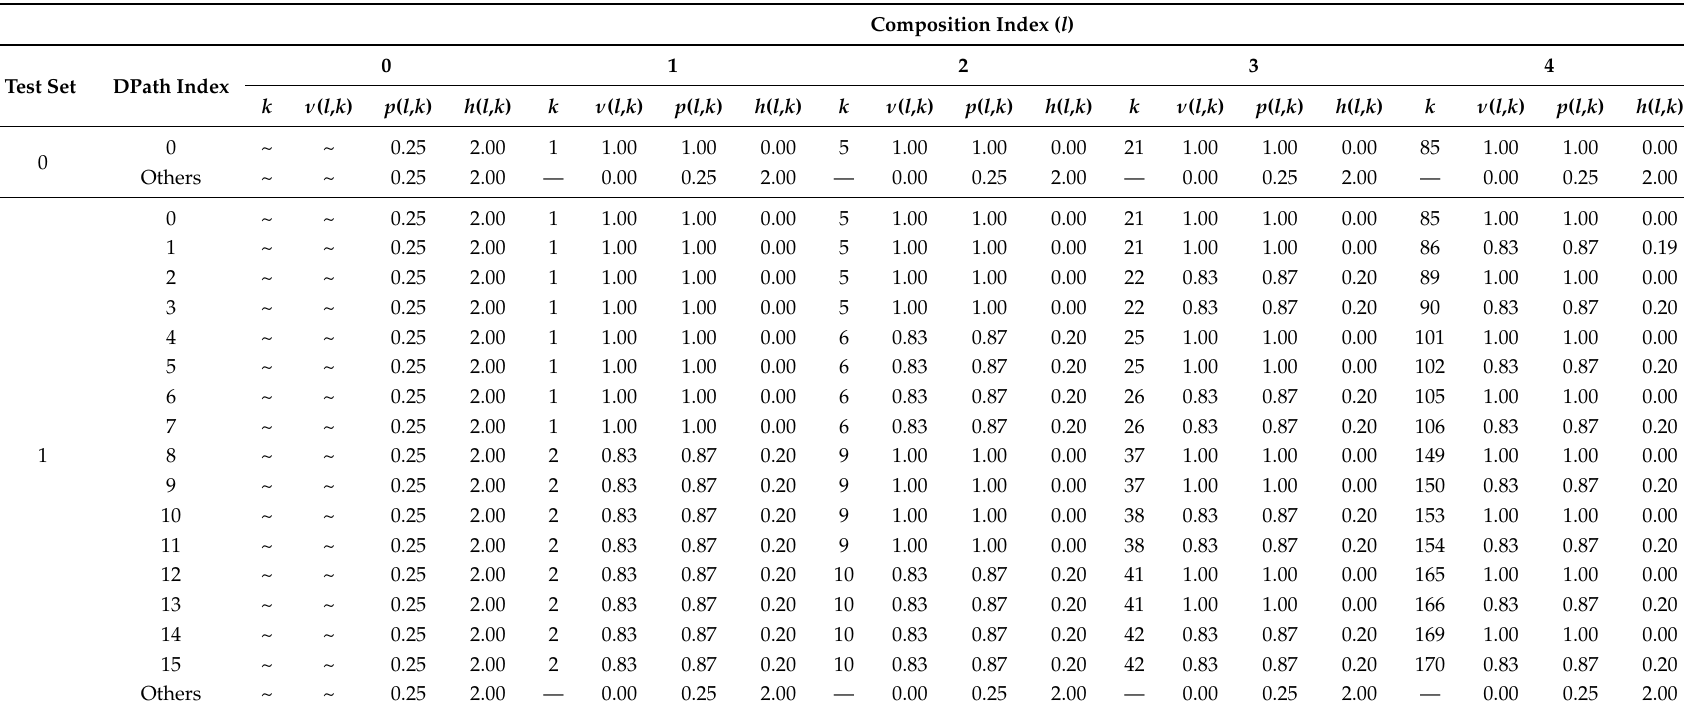
Table 3. Traversal mechanism parameters for DSpace traversals using Test Sets 0 and